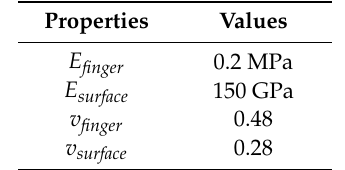
Figure 7. Estimated contact area versus applied load. Table 2. Parameters from the literature are used in the analytical model to estimate the contact area between the finger and counter-surface